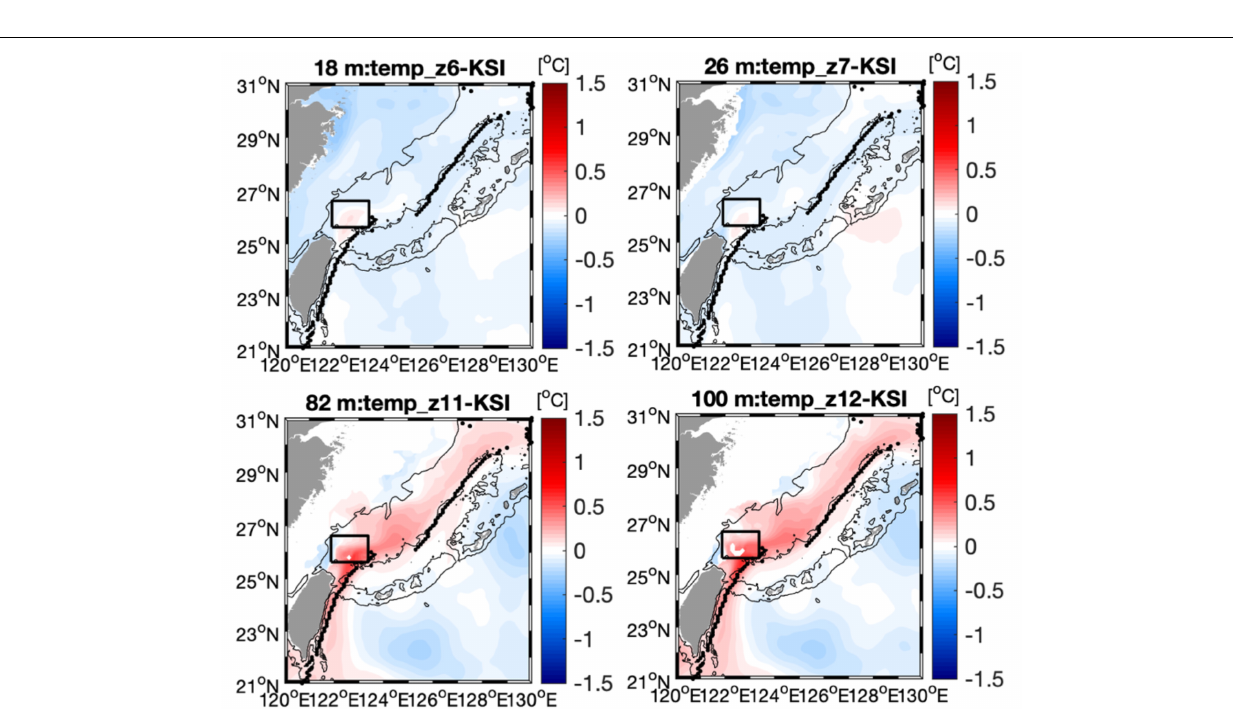
Frontiers in Marine Science |